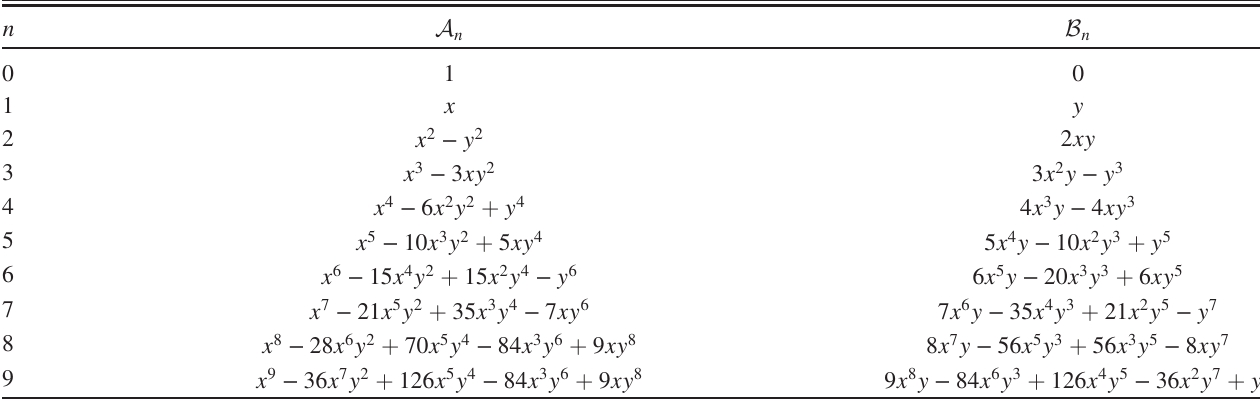
TABLE VII. Harmonic homogeneous polynomials in two